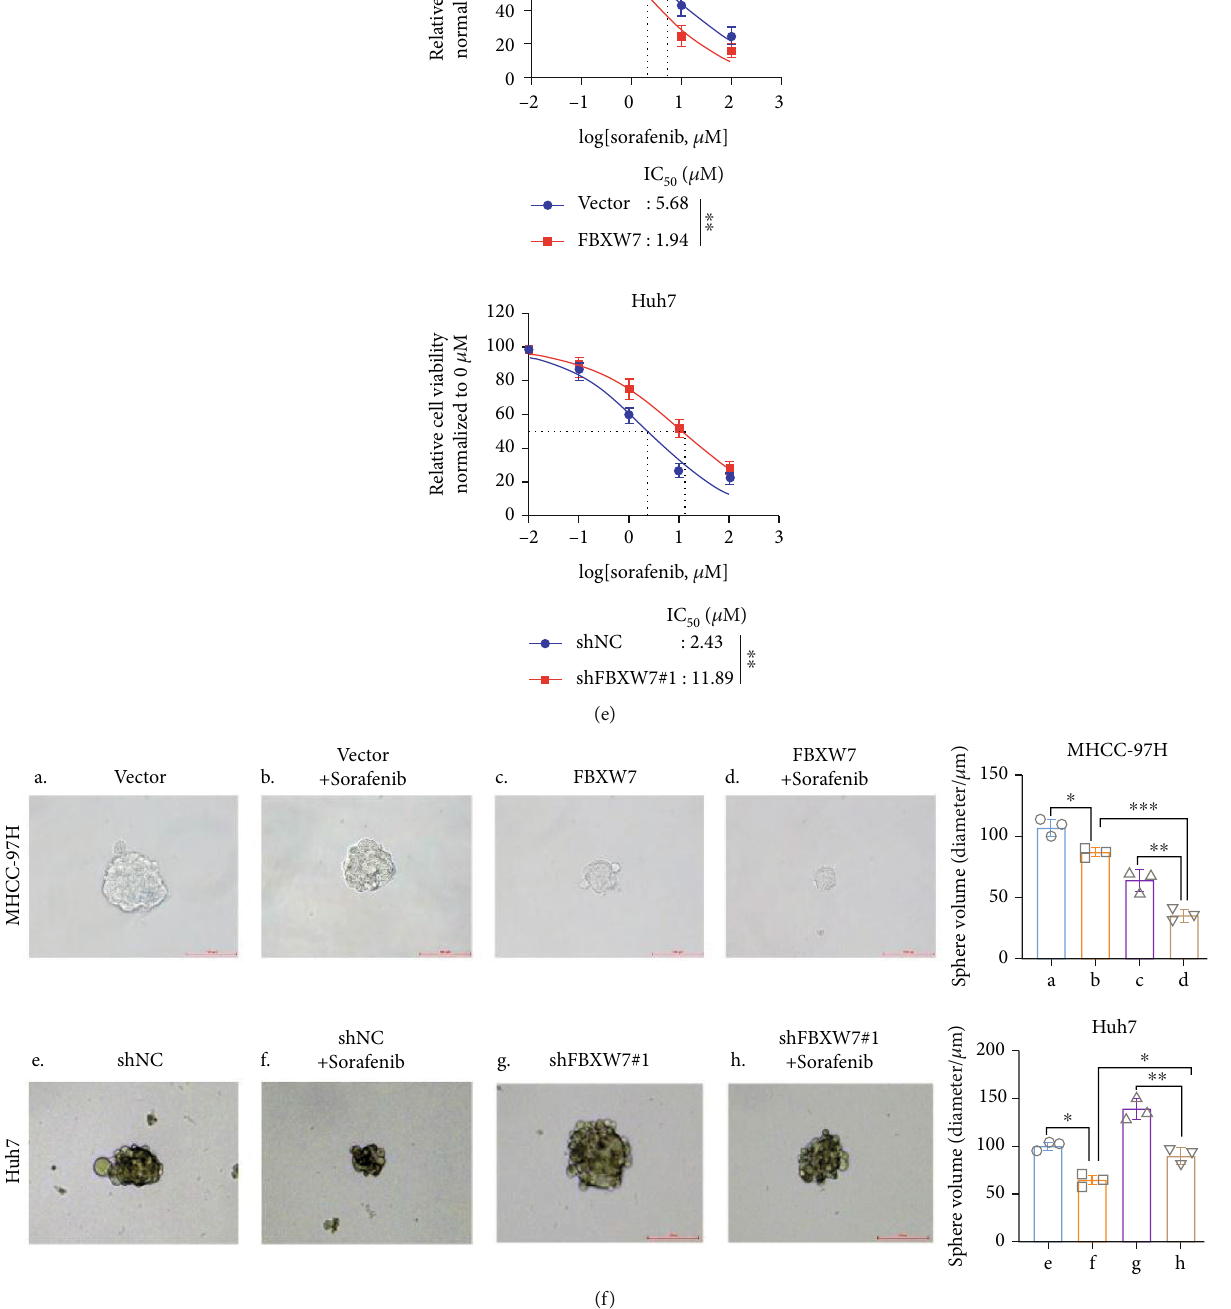
Figure 3: FBXW7 inhibits the tumorigenesis in vivo and interferes with sorafenib resistance of HCC cells. (a) Images of xenografts in nude mice 6 weeks after subcutaneous injection of indicated cells. (b, c) Xenograft tumors growth curve and weight. Tumor volume was calculated by ð length × width 2 Þ /2 . (d) IHC staining of FBXW7 and pluripotency-associated markers in respective xenograft tumor tissues. (e) FBXW7 overexpression increased the sensitivity to sorafenib, while FBXW7 knockdown reduced the sensitivity to sorafenib. (f) The in fl uence of FBXW7 or sorafenib on the sphere formation in MHCC-97H or Huh7 cells. Graph represents mean ± SD ; ∗ P < 0 : 05 , ∗∗ P < 0 : 01 , ∗∗∗ P < 0 : 001